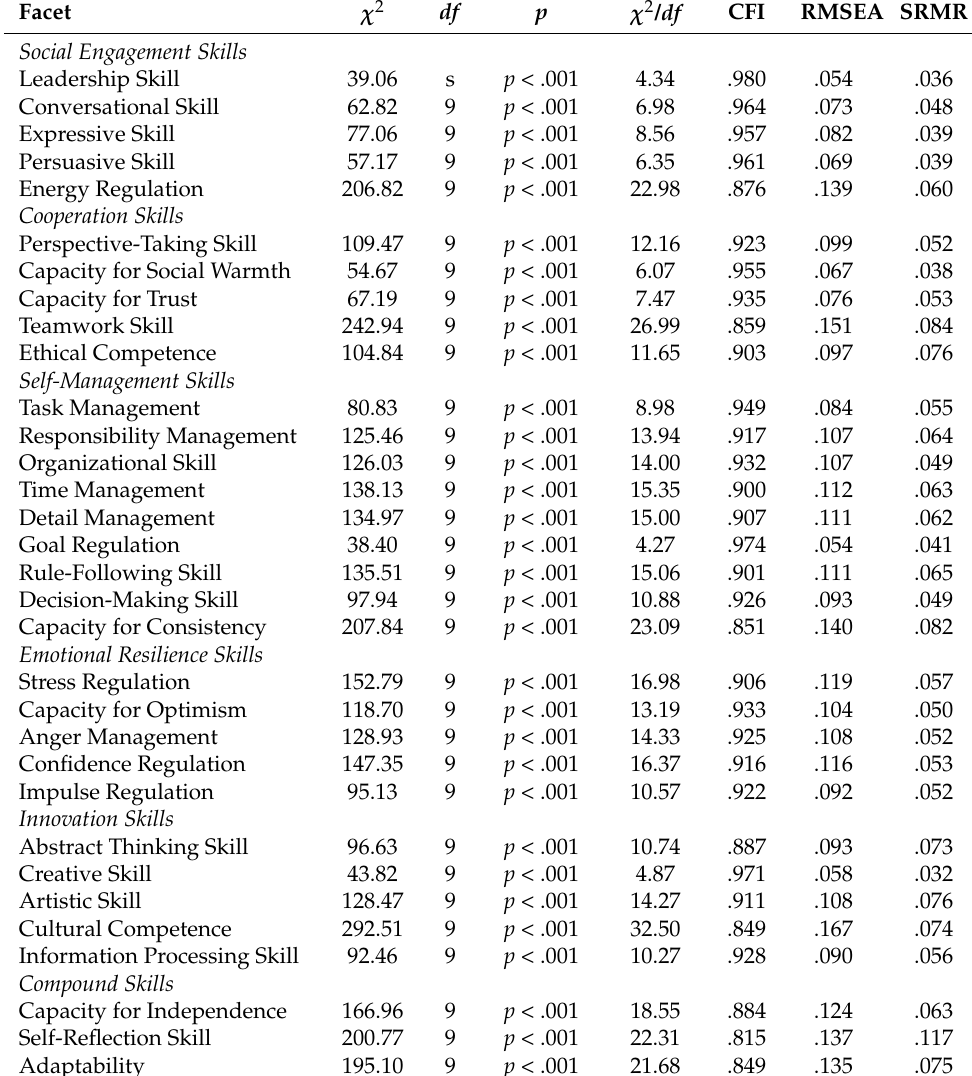
Table A3. Model fits of the 32 single-factor CFA models for BESSI-G v0.1 (Study